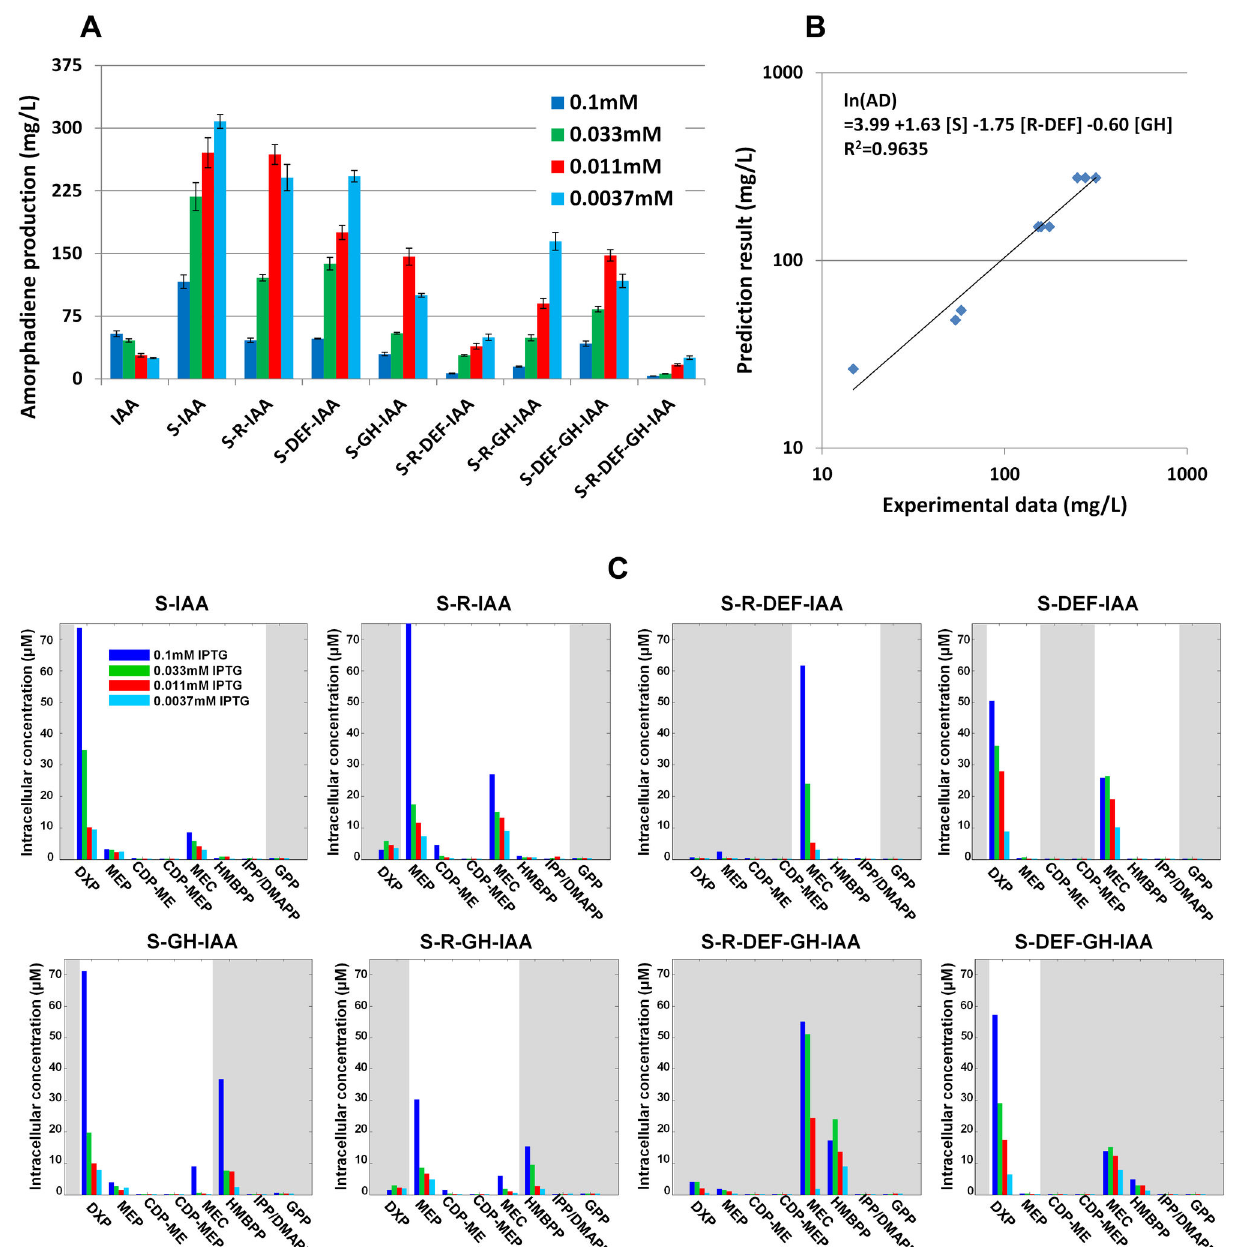
Figure 4. The performance of different combinations of DXP pathway genes in E . coli . (A) 48h amorphadiene yield. Different concentrations of IPTG were represented by bars with different colors. The experiment was repeated four times and the standard errors were shown. (B) The correlation of pathway modules with amorphadiene yield at optimal IPTG inductions. (C) Early response of intracellular metabolites at 3h after induction. The gray areas indicated the overexpressed section of DXP pathway. The experiment was repeated twice and the averages were